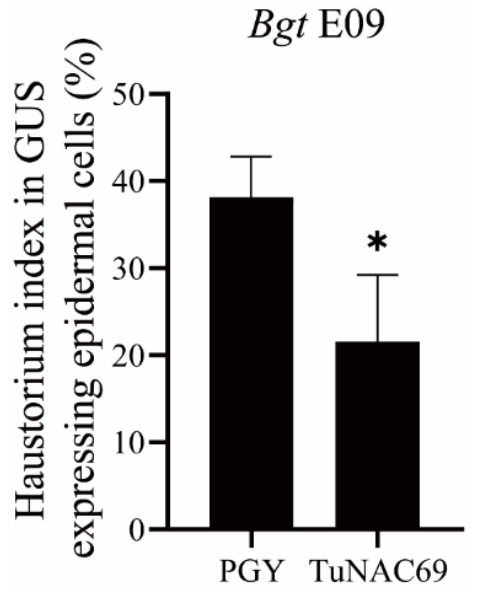
Figure 7. Transient overexpression of TuNAC69 enhanced the resistance to powdery mildew in wheat. Single-cell transient expression of TuNAC69 on the detached leaves of the susceptible wheat accession Fielder. Compared with control PGY , overexpression of TuNAC69 significantly reduced haustorium index after inoculation with Bgt E09. Statistically significant difference (Student’s t -test): *, p < 0.05.